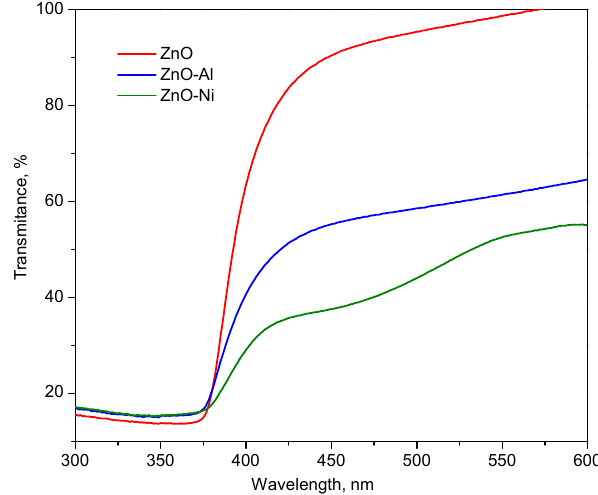
Figure 3. Optical transmission spectra of ZnO and doped ZnO nanoparticles.